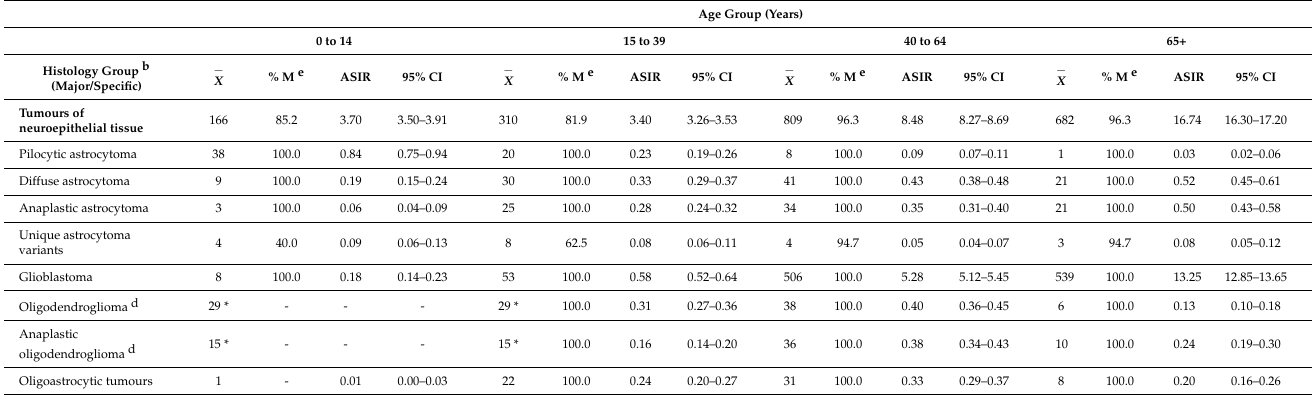
− X ), percent malignant e (% M), average annual age-standardized Table 2. Average annual cases ( incidence rates a (ASIRs, per 100,000 person-years) and associated 95% confidence intervals (CIs) for all primary CNS tumours diagnosed between 2010–2017 in Canada (excluding Quebec) by histology and age